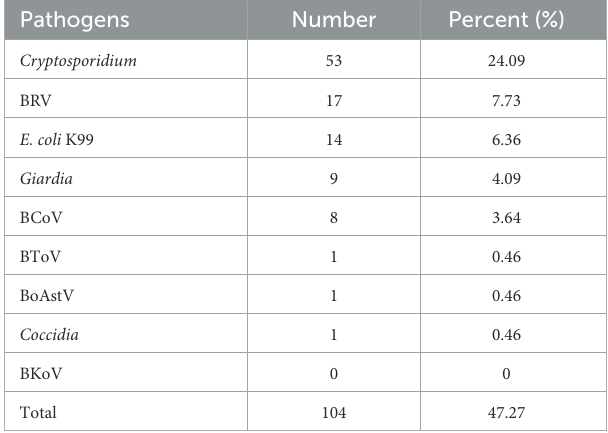
TABLE 4 The details of calf diarrhea single